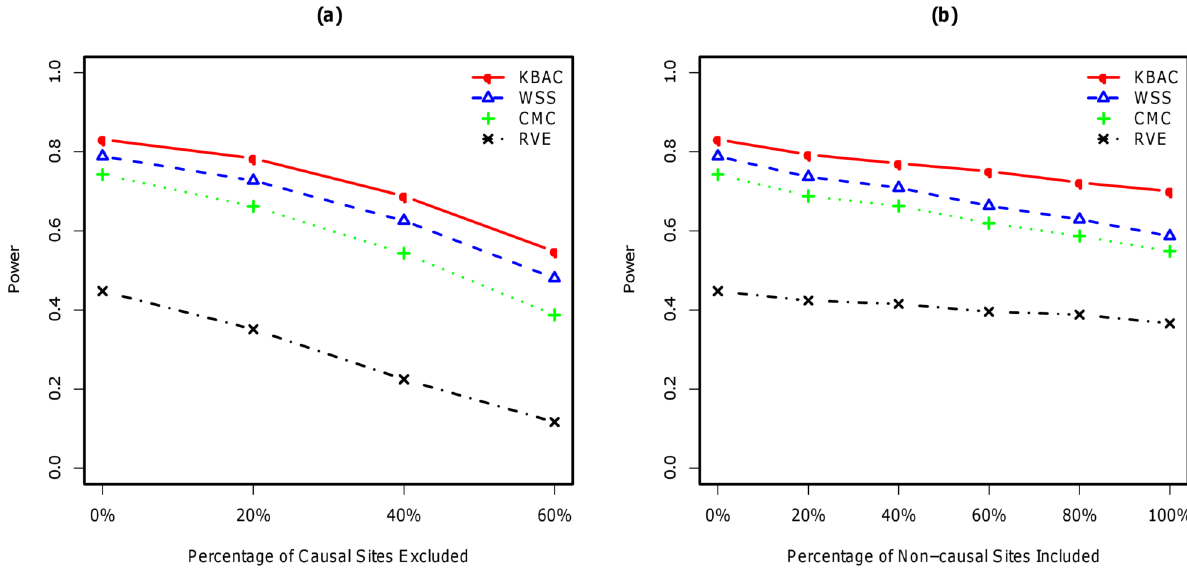
Figure 3. Impact of misclassifications under main effects model with variable genetic effects using simulated SFS for AA. The disease odds for causal variants are inversely correlated with their MAFs and within the range of 2 , 20. Power comparisons were made for the KBAC, WSS, CMC, and RVE when 0% , 60% of causal rare variants are excluded from the analysis (left panel) and when 0% , 100% of non-causal rare variants are included (right panel). A sample size of 1000 cases and 1000 controls was used for each scenario. P-values were empirically estimated using 5,000 permutations and power was evaluated for a significance level of a ~ 0 : 05 using 2,000 replicates for each scenario. doi:10.1371/journal.pgen.1001156.g003 shown in (Figure S4) for fixed effects and in (Figure S5) variable effects models and that with estimated SFS for EA are displayed in (Figure S6) for fixed and in (Figure S7) for variable genetic effects models.